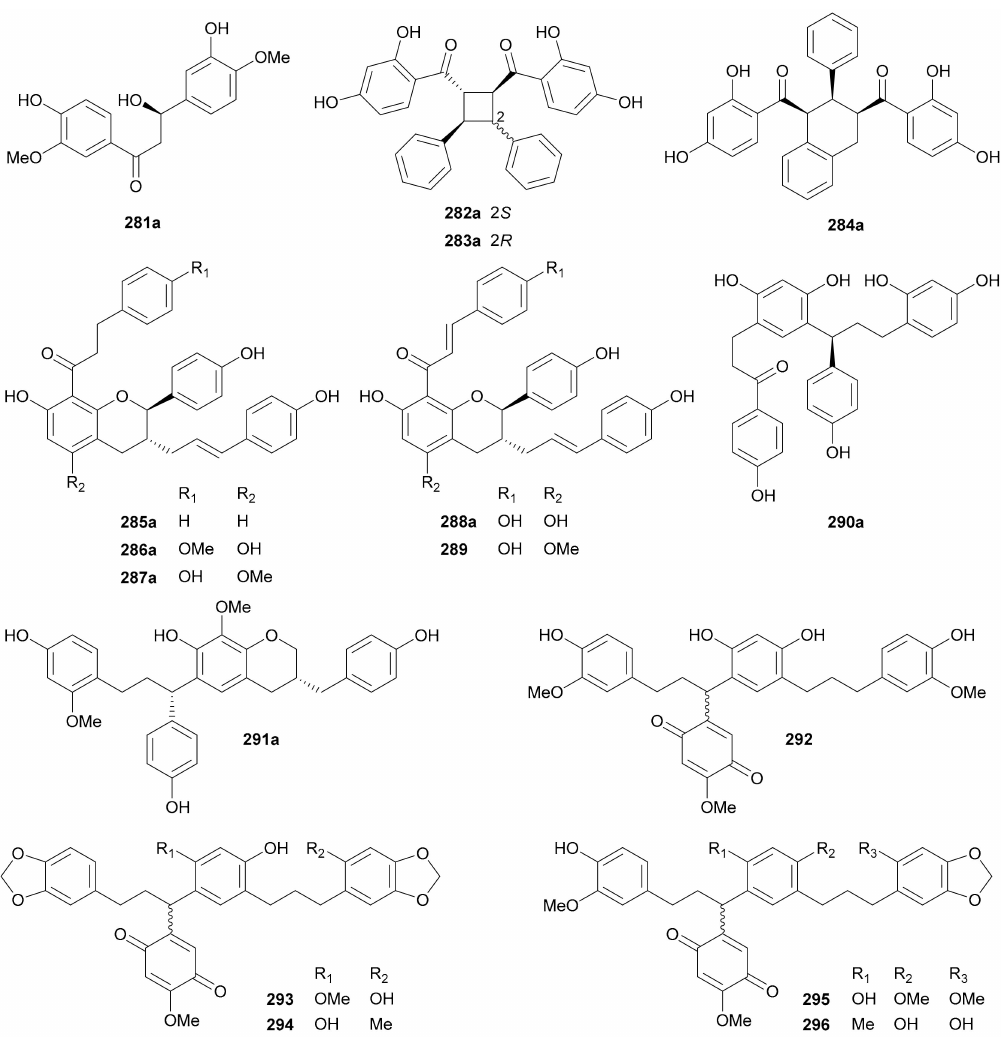
Figure 16. Structures of